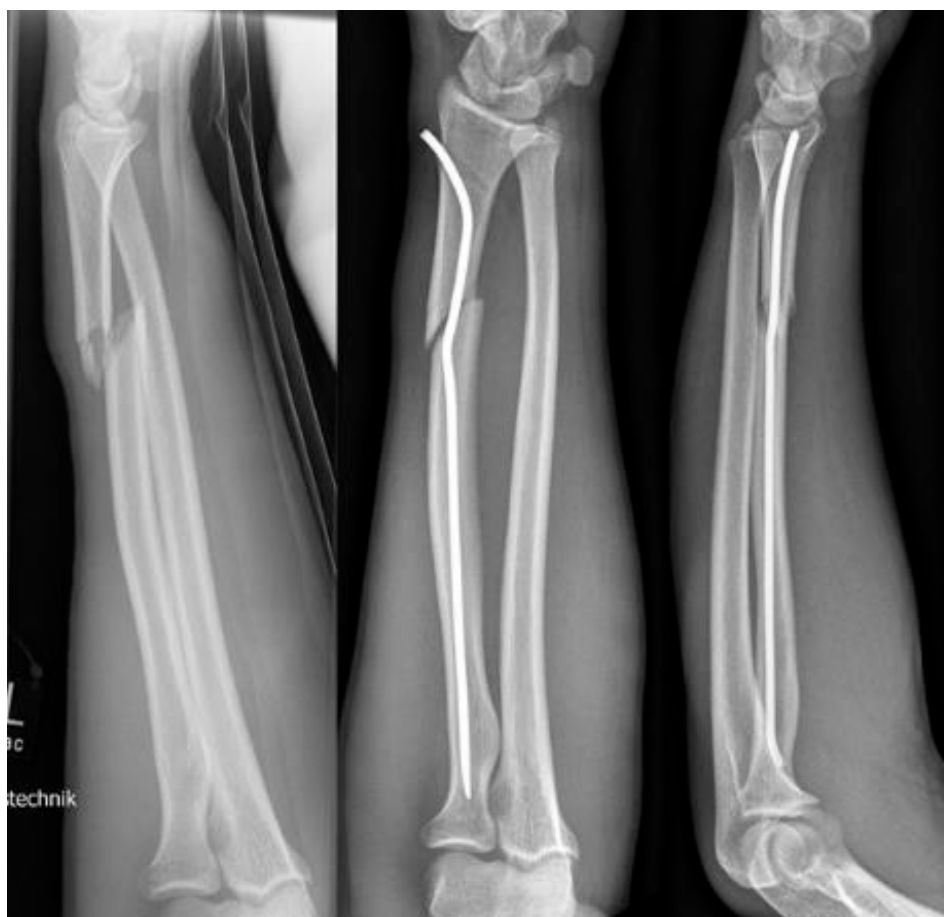
Scheme 3. 17-year-old boy.